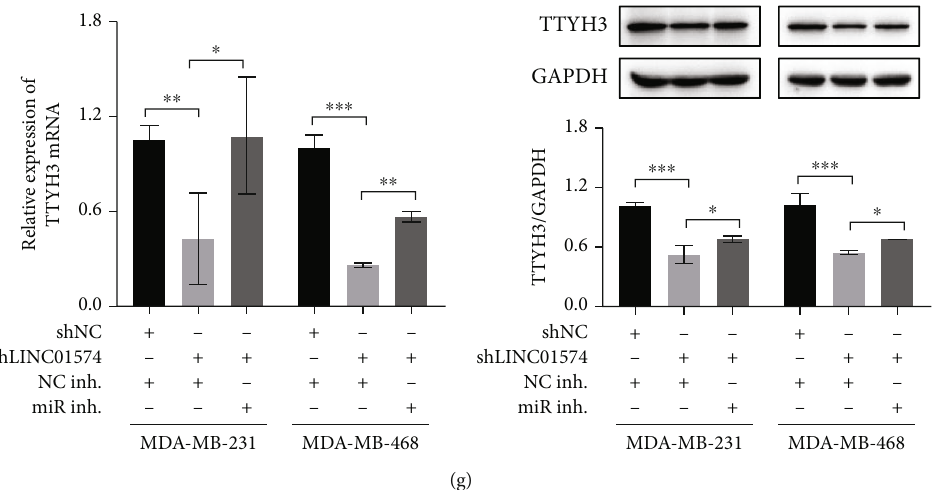
Figure 5: LINC01574 a ff ected TTYH3 expression by regulation of miR-6745. (a) miRWalk, TargetScan7, and miRDB algorithm were used to predicted downstream target mRNAs with potential binding sites for miR-6745. (b) TCGA and CPTAC databases were used to analyze the expression of TTYH3 and survival in BC patients. (c) QRT-PCR quantitatively detected the transcriptional expression of TTYH3 in BC tumor tissues. (d) After corresponding transfection, the mRNA level of miR-6745 and TTYH3 and the protein level of TTYH3 were analyzed. (e) The interaction between miR-6745 and TTYH3 was veri fi ed through luciferase reporter assay. (f, g) After corresponding transfection, the mRNA level of miR-6745 and TTYH3 and the protein level of TTYH3 were analyzed. ∗ P < 0 : 05 , ∗∗ P < 0 : 01 , and ∗∗∗ P < 0 : 001 e ff ect of silencing LINC01574 on lung metastasis of BC cells